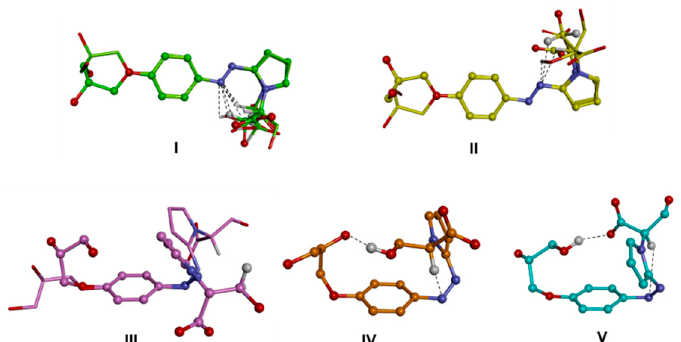
Figure 5. Conformational families of the trans (up; I , II ) and cis (down; III – V ) isomers of d 1RR in their anionic form. The lowest energy conformer of each family is displayed as a ball and sticks. Conformers belonging to subfamilies are superimposed by phenyl ring atoms and displayed as a stick. Heteroatoms are coloured by atom type: O, red; N, blue. Hydrogens are omitted for clarity with the exception of those involved in intramolecular interactions (evidenced with a black dashed line).